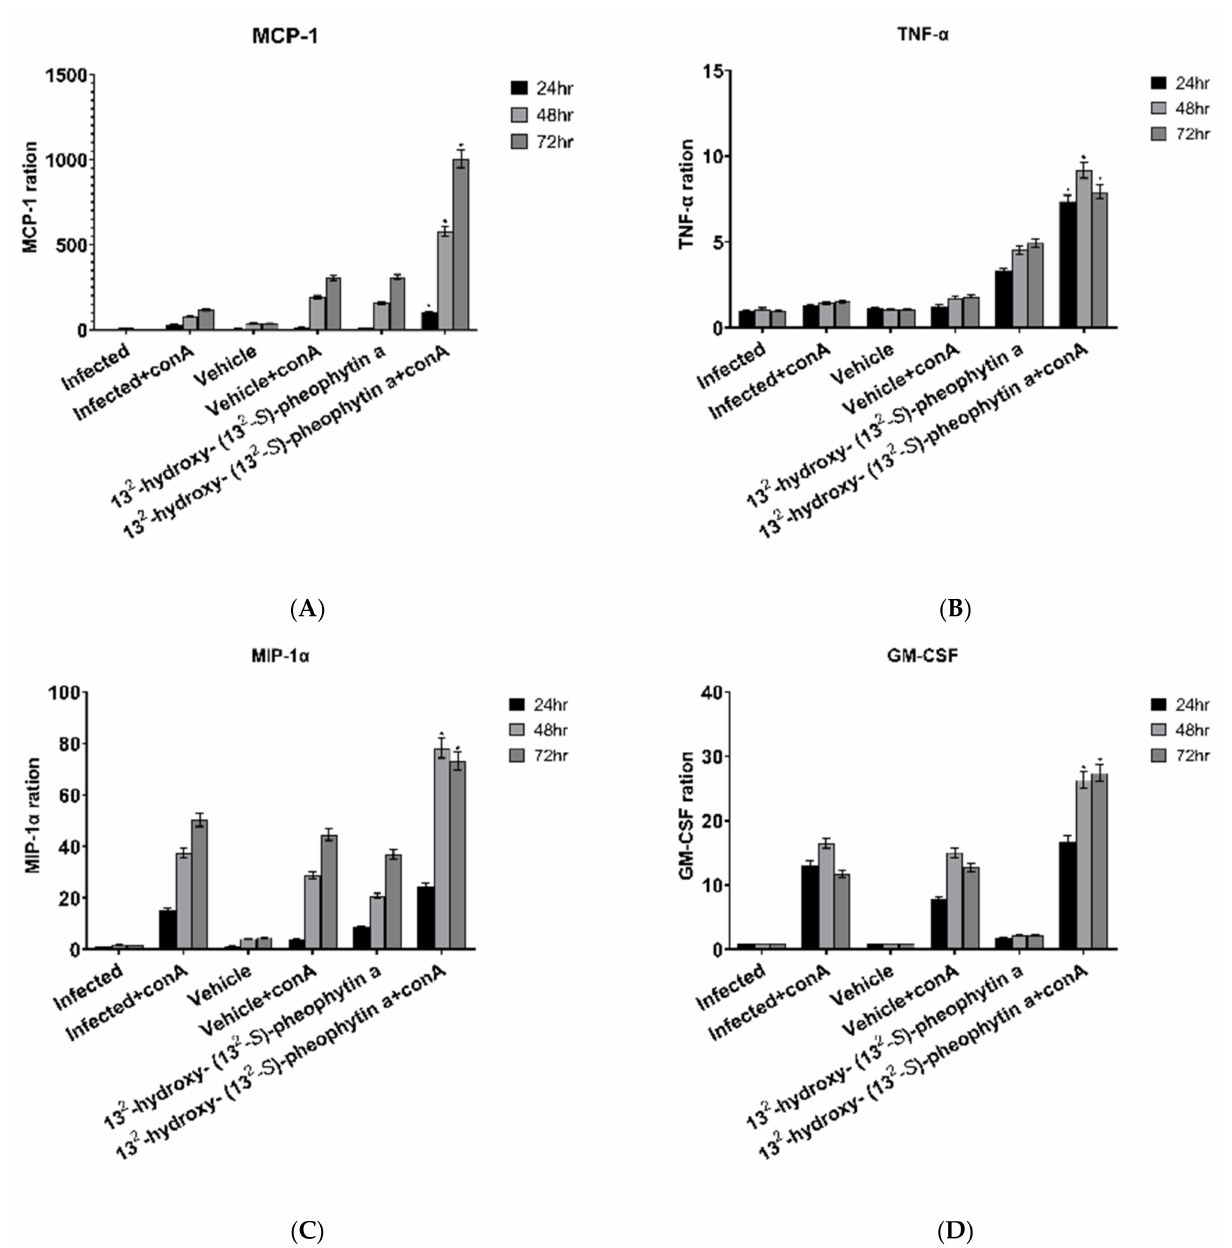
Figure 9. Chemokine production in spleen cells postinfection with H. nana for 10 days. Cell media of spleen cells were harvested to determine MCP-1, TNF- α , MIP-1 α , and GM-CSF after 24, 48, and 72 h incubation. Infected group: male BALB/c mice infected by H. nana without treatment in vivo. Vehicle and 13 2 -hydroxy-(13 2 -S)-pheophytin a group: infected groups were treated with vehicle or 13 2 -hydroxy-(13 2 -S)-pheophytin a at 0.025 g/kg/day for 10 days in vivo. Con A: spleen cells were cultured with concanavalin A. MCP-1, TNF- α , MIP-1 α , and GM-CSF ratios are shown at 24, 48, and 72 h of incubation ( A – D ). * p < 0.05 indicates a statistical significance from infected + con A